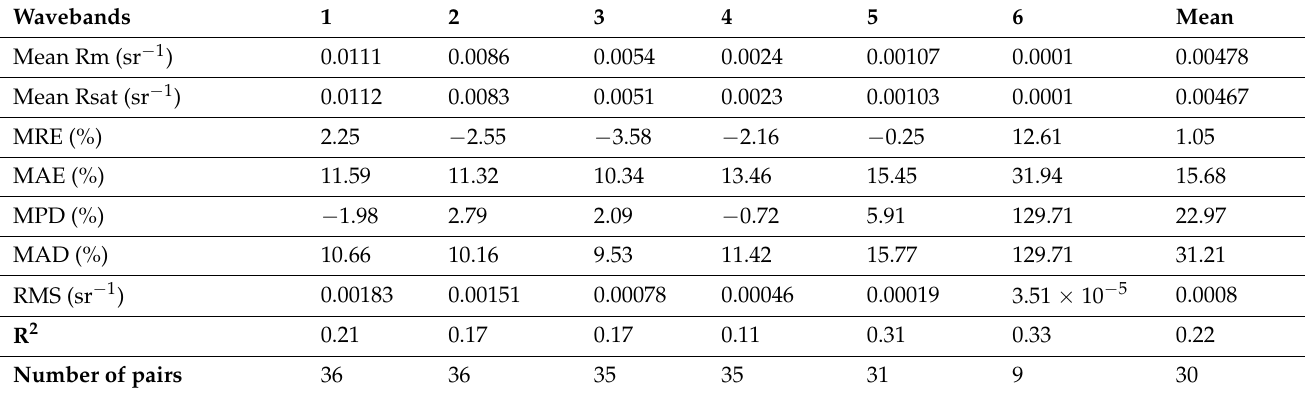
Table 3. Comparison of the R rs between the COCTS/HY-1D and MOBY measurements.